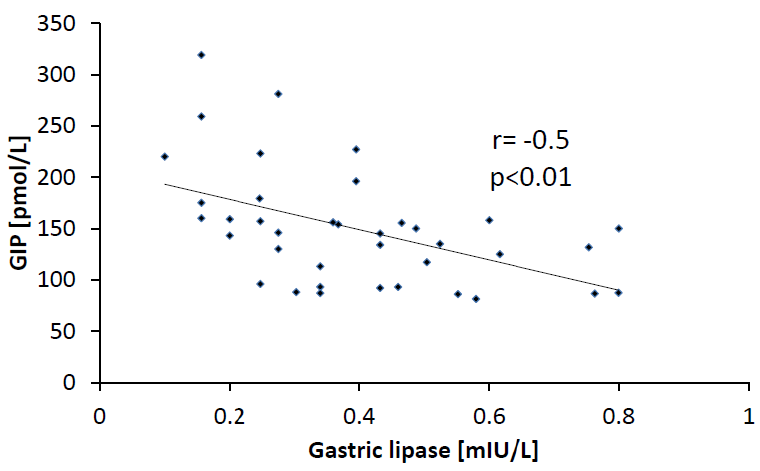
Figure 2. Correlation between activity of HGL and concentration of GIP in all studied